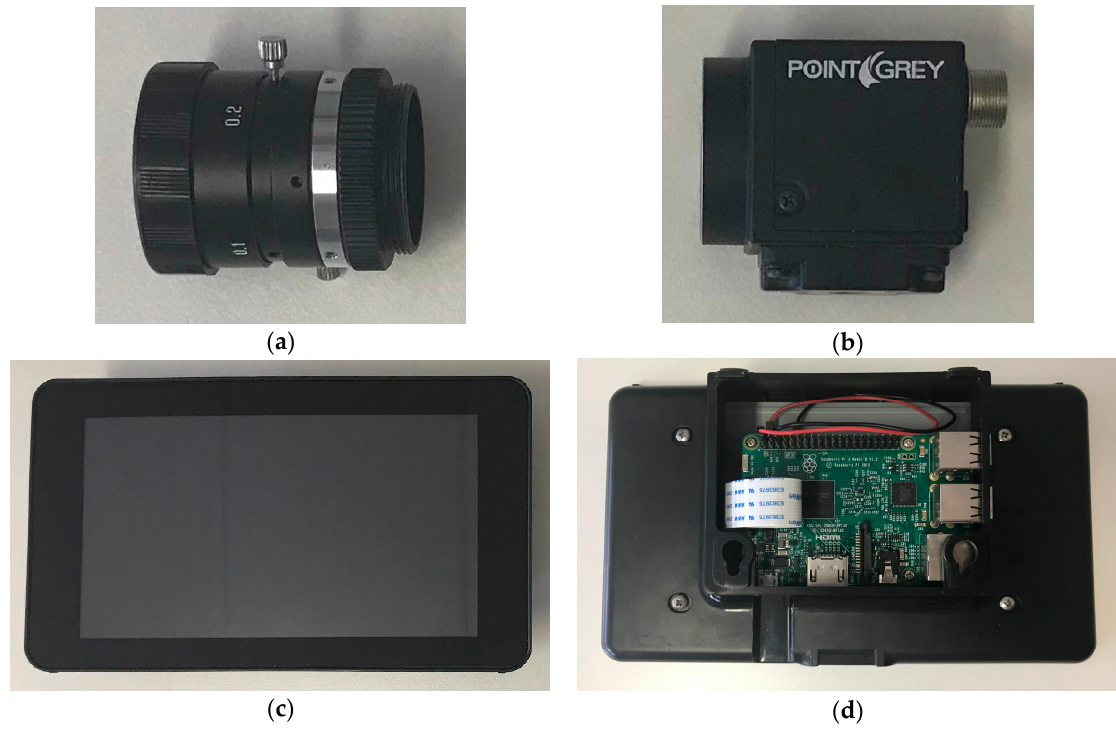
Figure 4. Components of the camera system: ( a ) camera lens, ( b ) camera, ( c ) Raspberry Pi computer touch screen, and ( d ) Raspberry Pi computer and case. Table 1. Approximate cost of the components of the camera system excluding any taxes. Site installation costs are not included. Prices shown are costs obtained as at the time of publication. Items purchased in AU$ were converted to US$ at the rate of